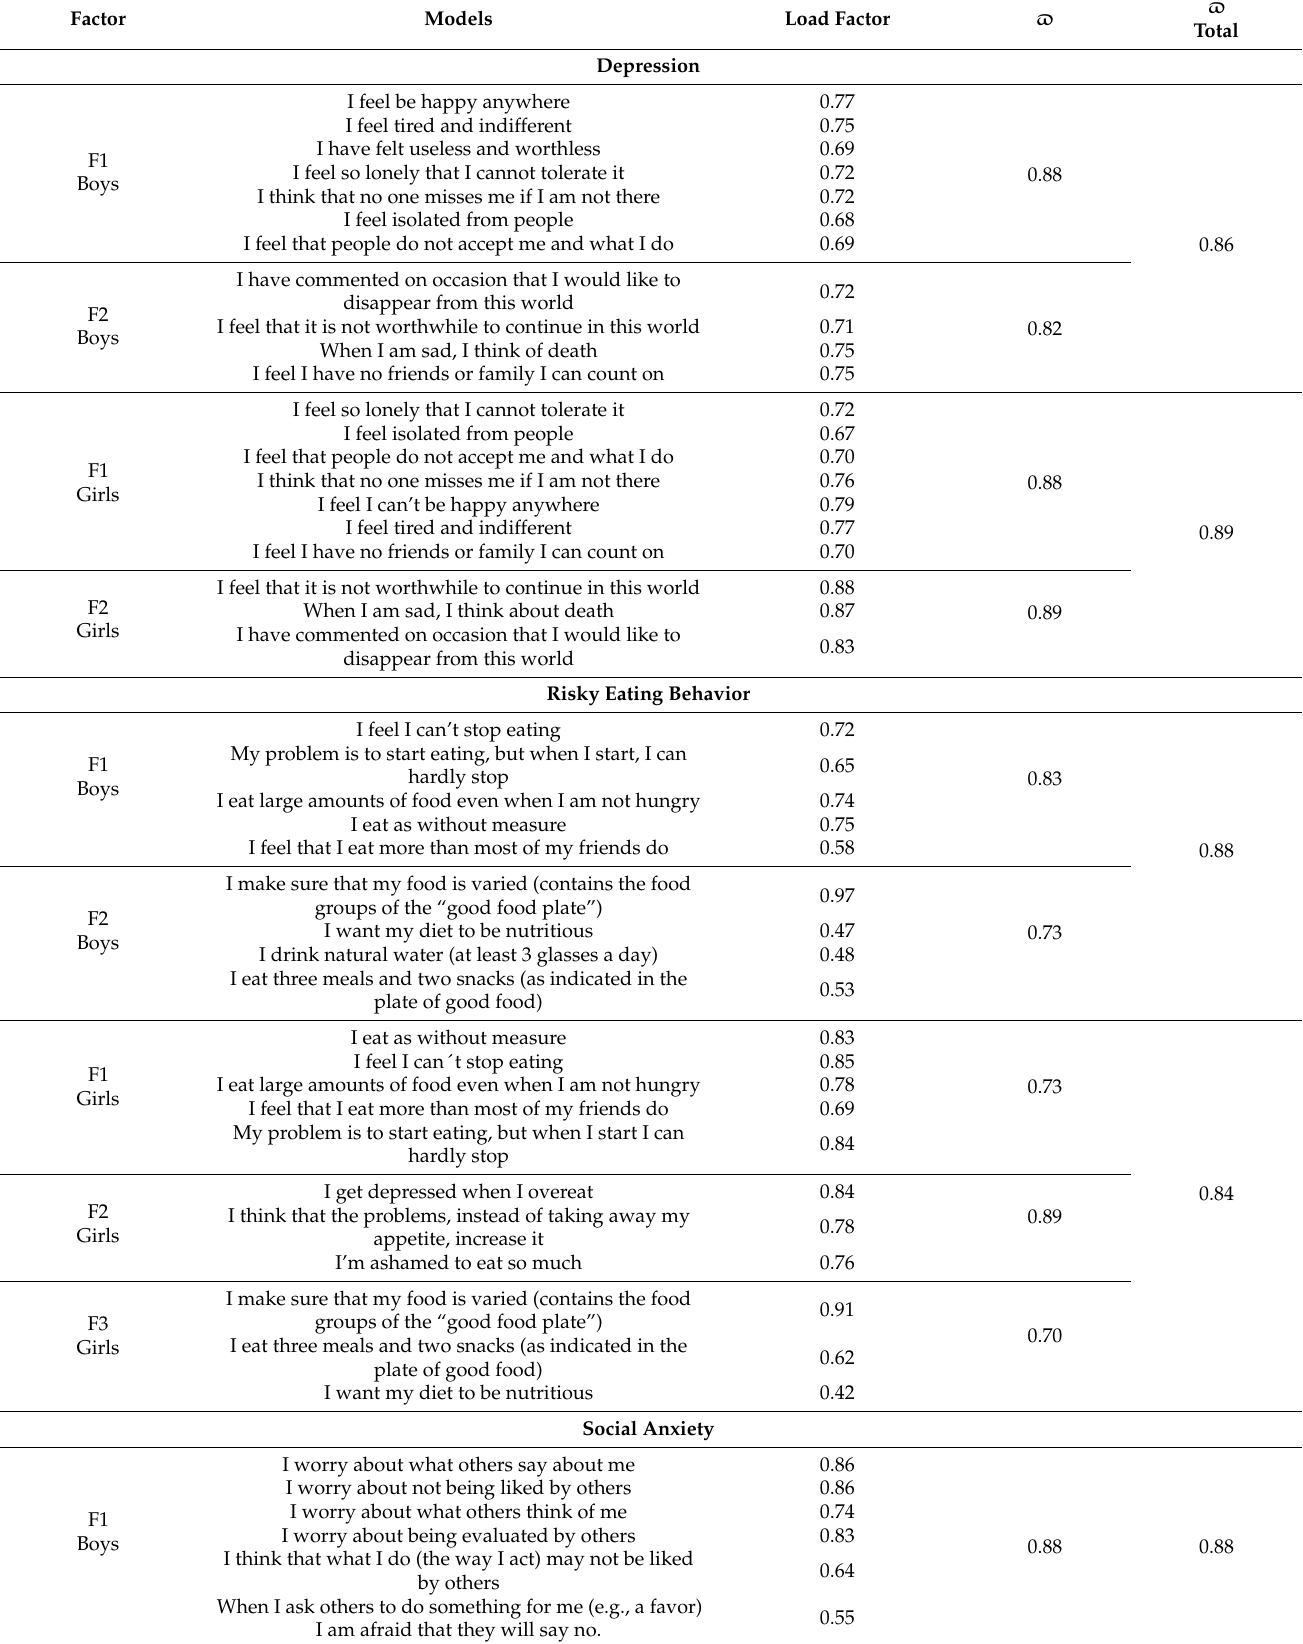
Table 2. Depression, REB, and Social Anxiety models for boys and